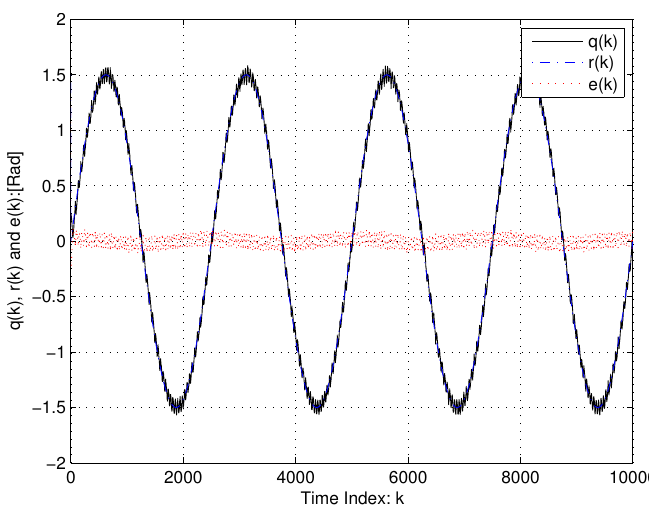
Figure 13. Tracking performance: Controller A.